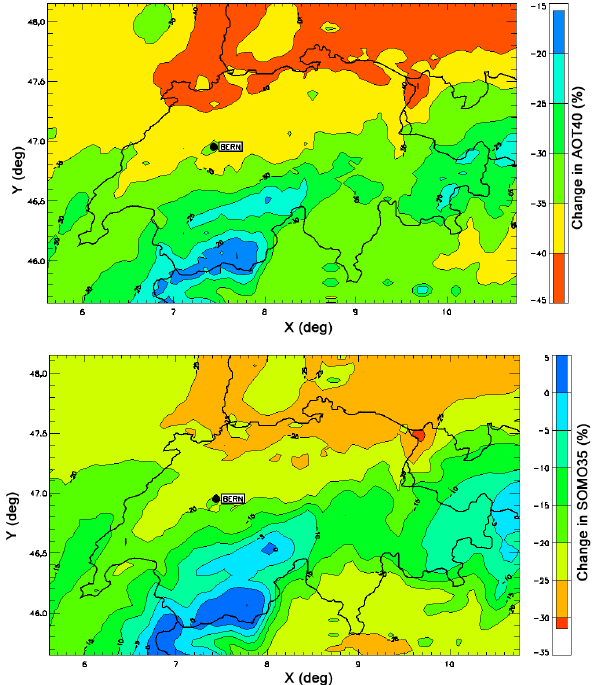
Figure 12. Relative changes in AOT40 (upper panel) and in SOMO35 (lower panel) over the Swiss domain, 2005–1990.